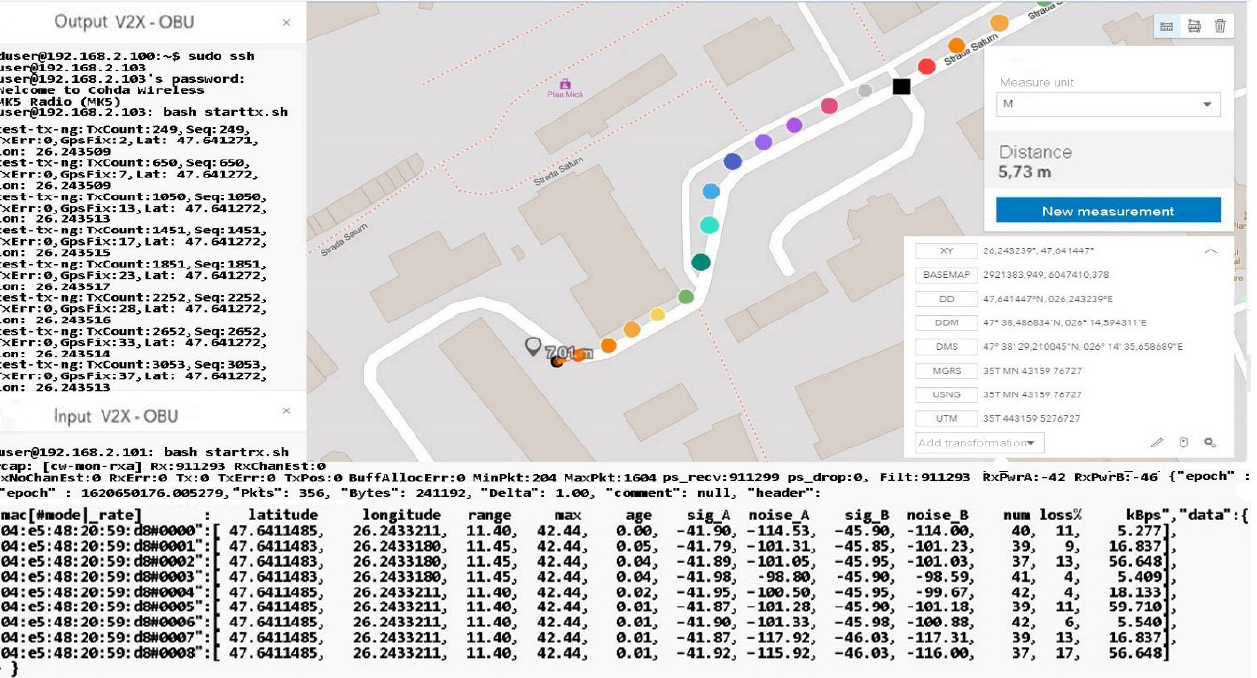
Figure 28. Simulated scenario at a distance of 7 m from the transmitter in a controlled environment. The synchronization of the systems in short-distance conditions competes without problems. According to the inputs received at the reception, the highest threshold of lost packets is counted next to packets totaling over 56 kBps, about 17%, while in other cases, the losses are negligible.